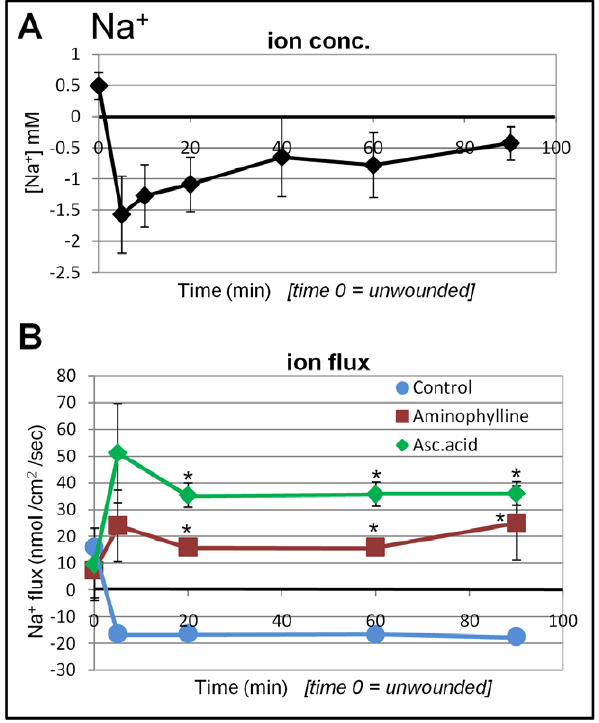
Figure 5. Sodium flux at corneal wounds. A. Na + concentration. Unwounded cornea had a slighly higher Na + concentration than background. However, upon wounding, the Na + concentration at the wound edge was lower than background (negative values). B. Na + flux. Intact cornea showed a small Na + efflux. On wounding this became a sodium influx which was maintained for 90 min. Both aminophylline and ascorbic acid induced a large Na + efflux at later timepoints (5 min and later; *P , 0.01). doi:10.1371/journal.pone.0017411.g005 needle (WPI; cat # SSM33A70) with a platinum ball electroplated